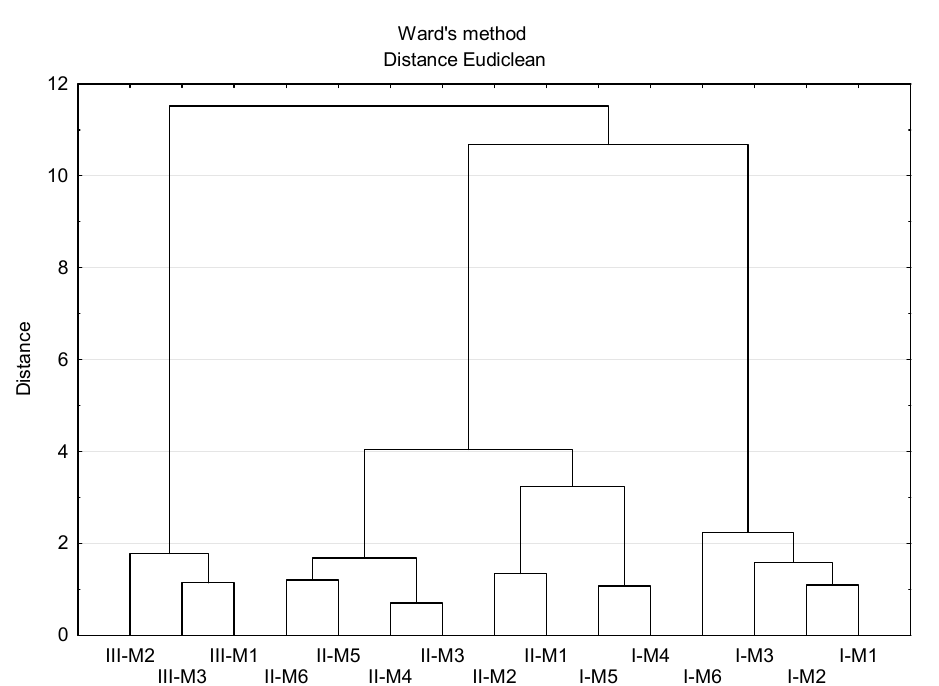
Figure 4. Ward’s cluster analysis for grass mixtures (objects) with F. braunii based on average content of: crude protein, soluble sugars, crude fiber, the net energy and sward dry matter yield. The vertical line (linkage distance 4) indicates the cut-off used to form the groups (1–4). Explanations: I-M1: I-experiment no. -M1-grass mixture no.